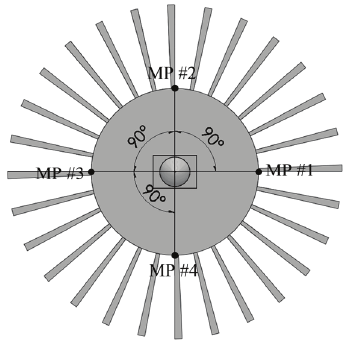
Fig. 6. Measurement points for assessing the average